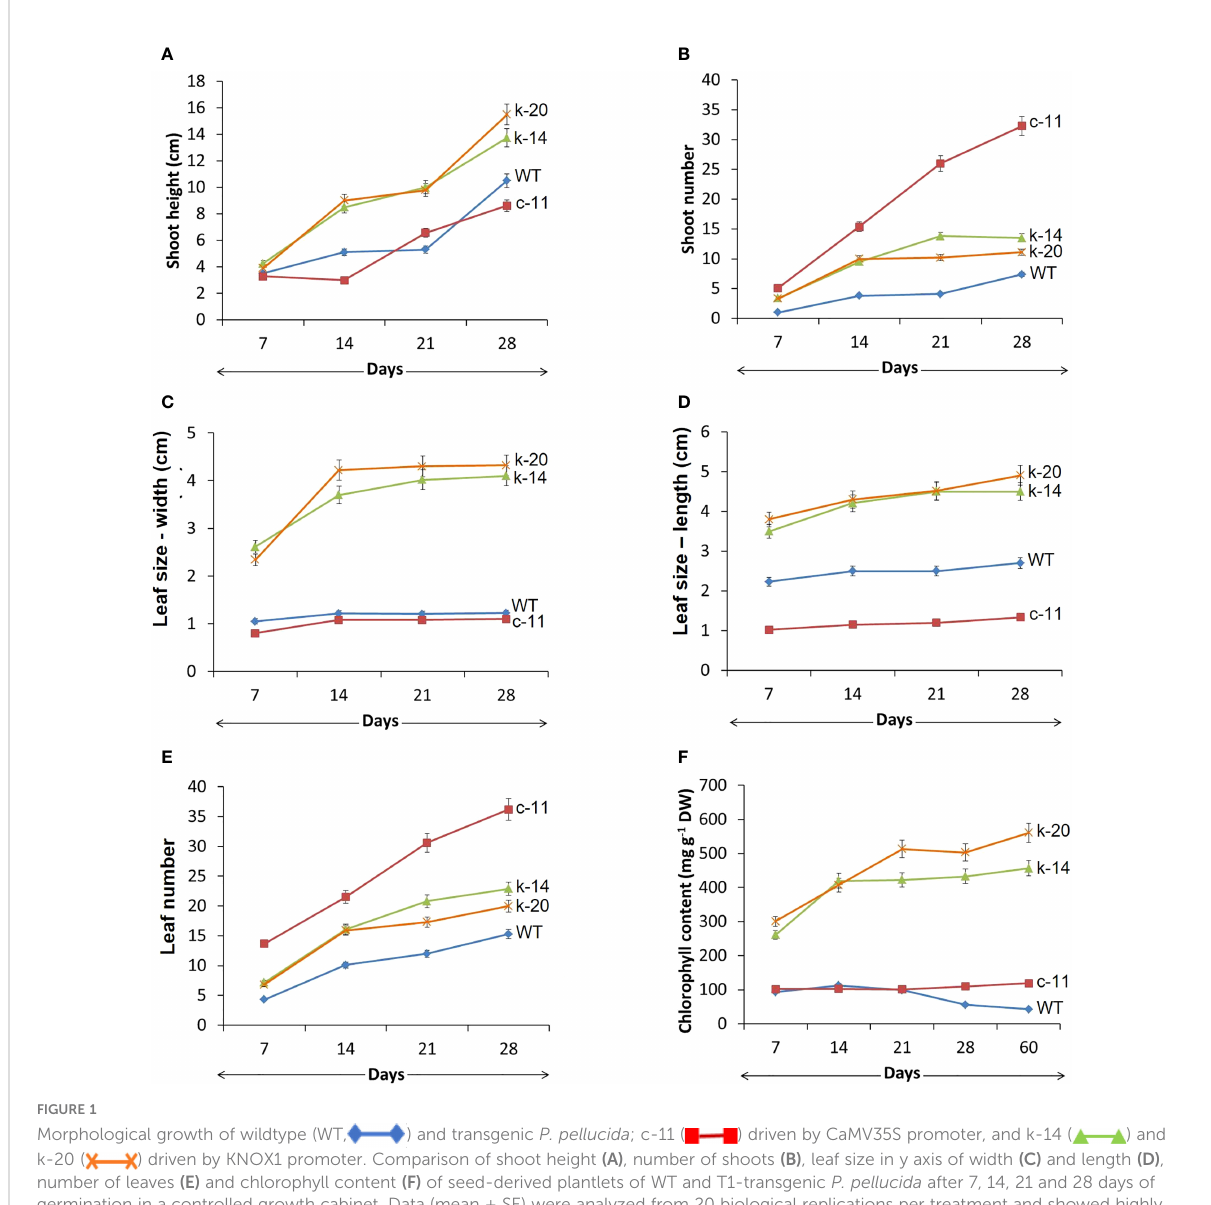
FIGURE 1 Morphological growth of wildtype (WT, ) and transgenic P. pellucida ; c-11 ( ) driven by CaMV35S promoter, and k-14 ( ) and k-20 ( ) driven by KNOX1 promoter. Comparison of shoot height (A) , number of shoots (B) , leaf size in y axis of width (C) and length (D) , number of leaves (E) and chlorophyll content (F) of seed-derived plantlets of WT and T1-transgenic P. pellucida after 7, 14, 21 and 28 days of germination in a controlled growth cabinet. Data (mean ± SE) were analyzed from 20 biological replications per treatment and showed highly signi fi cant difference at p ≤ 0.01. Line c-12 obtained from p35S transgenic plants remained only two biological replications, which could not perform for statistical